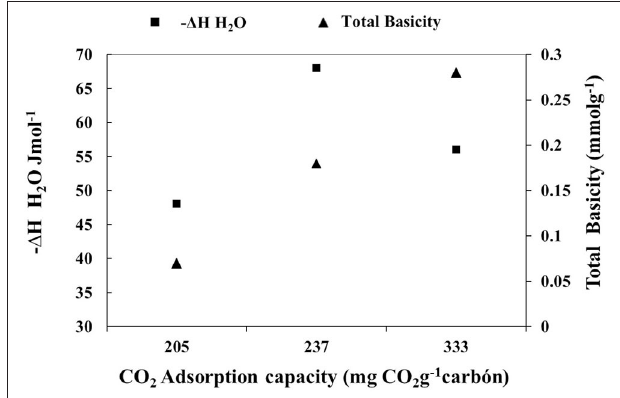
FIGURE 8 | Relationship between the CO 2 adsorption capacity of activated carbon with the enthalpy of immersion in H 2 O and the total basicity of solids.